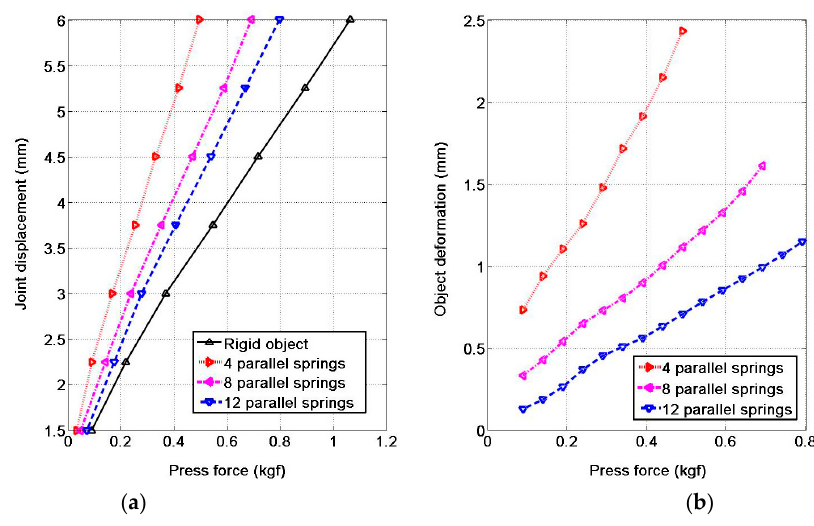
Figure 10. The experiment result of softness. ( a ) the raw data; ( b ) the curve of softness.